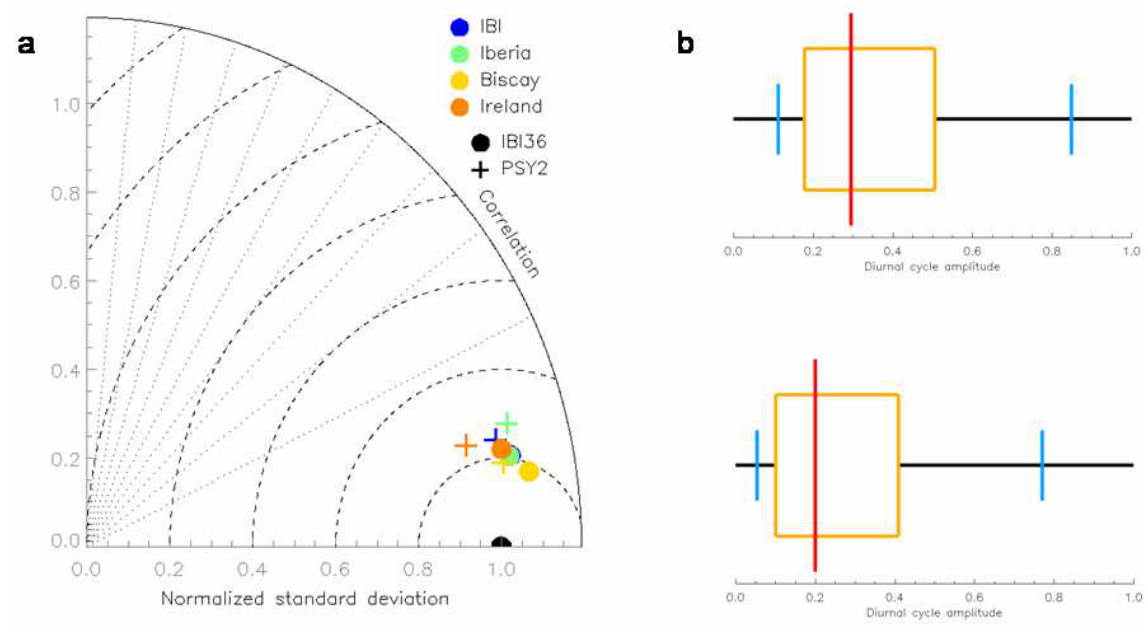
Fig. 7. Left (a) : Taylor diagram of the 1-day low-pass-filtered SST at buoy locations in different regions. Filled dots are for comparisons with IBI and crosses are for comparisons with PSY2V3. Results are presented for the model domain and also for the following subregions: the “Iberia” region, delimited by 36.5 ◦ N–44 ◦ N,10.5 ◦ W–6.5 ◦ W, the “Biscay” region delimited by 43 ◦ N–48.5 ◦ N,8 ◦ W–1 ◦ W, the “Ireland” region delimited by 51 ◦ N–56 ◦ N,9 ◦ W–3 ◦ W. Right (b) : box plot of the diurnal cycle computed from data (top) and from model (bottom). The distribution is described with percentiles of data (vertical lines). From the left to the right, the positions of the 10th percentile (blue), the lower quartile (yellow), the median (red), the upper quartile (yellow) and the 90th percentile (blue) are indicated.